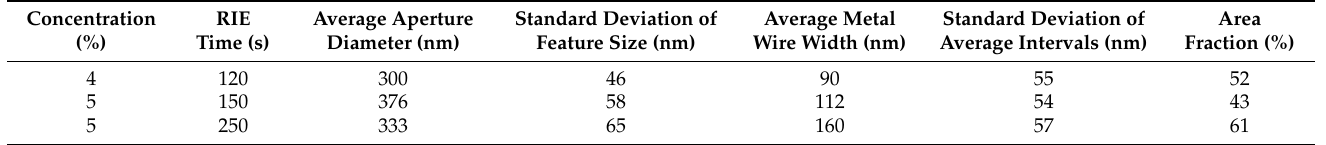
Table 2. Summarization of feature size distribution of apertures and metal wires in Au nanomesh film samples with various polymer blend solution concentrations and RIE time. The weight ratios of PS/PPSQ were all set as 1:1. The number of items counted is 100 for each